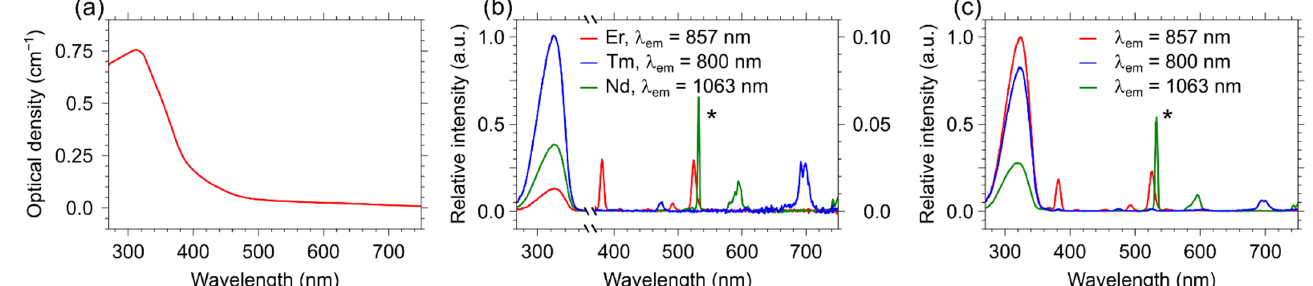
Figure 3. ( a ) Optical absorption spectra of pure YVO 4 particles; ( b ) excitation spectra of the single- doped YVO 4 : Nd 3+ (0.03 at.%), YVO 4 : Er 3+ (3 at.%), and YVO 4 : Tm 3+ (1 at.%) samples and ( c ) triple- doped YVO 4 : Nd 3+ (0.03 at.%), Er 3+ (3 at.%), and Tm 3+ (1 at.%) samples monitored at different wavelengths λ em = 1064, 857, and 800 nm corresponding to the luminescence emission bands of Nd, Er, and Tm, respectively. The asterisk (*) indicates the second order of diffraction.